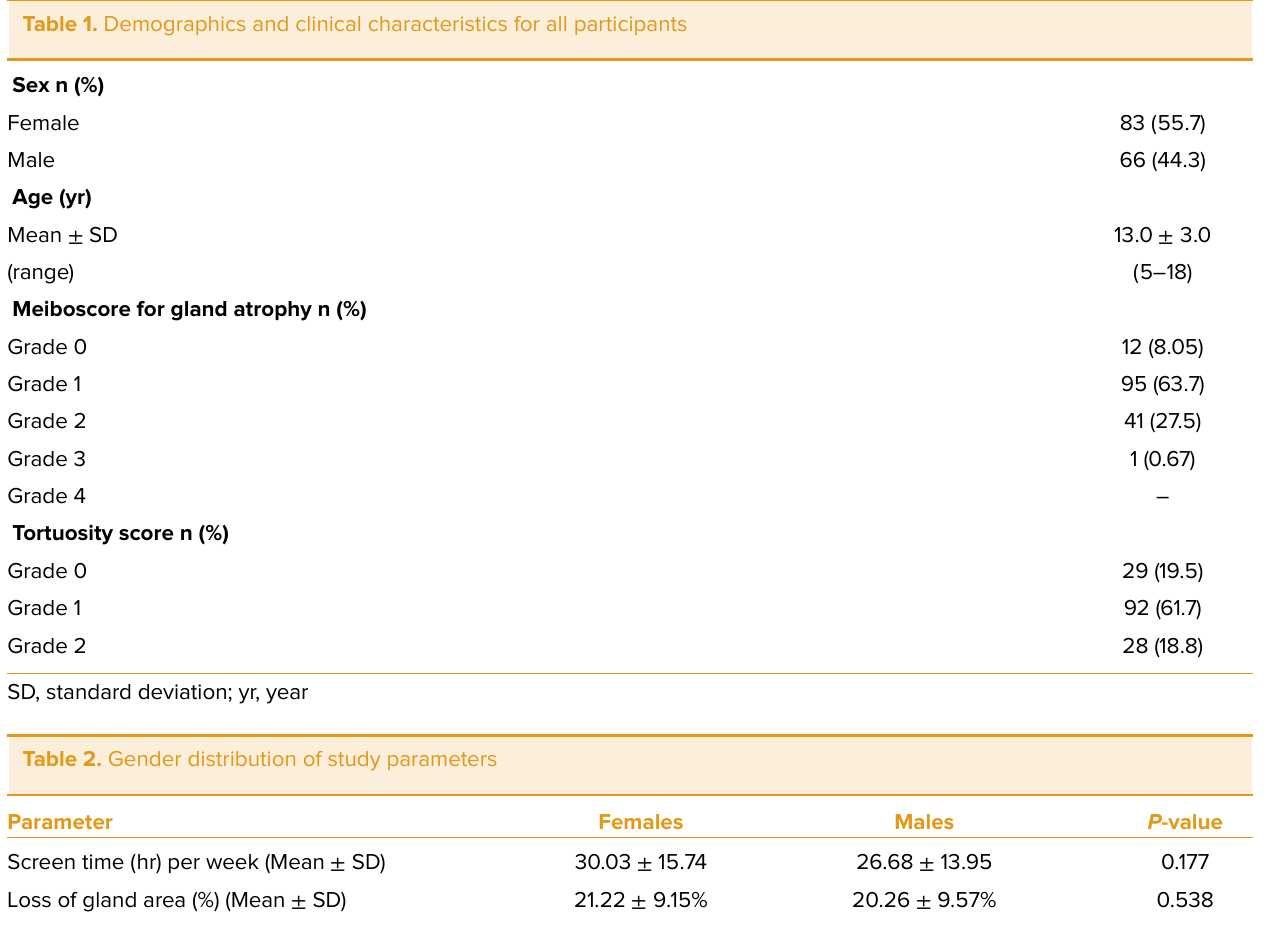
Table 1. Demographics and clinical characteristics for all participants